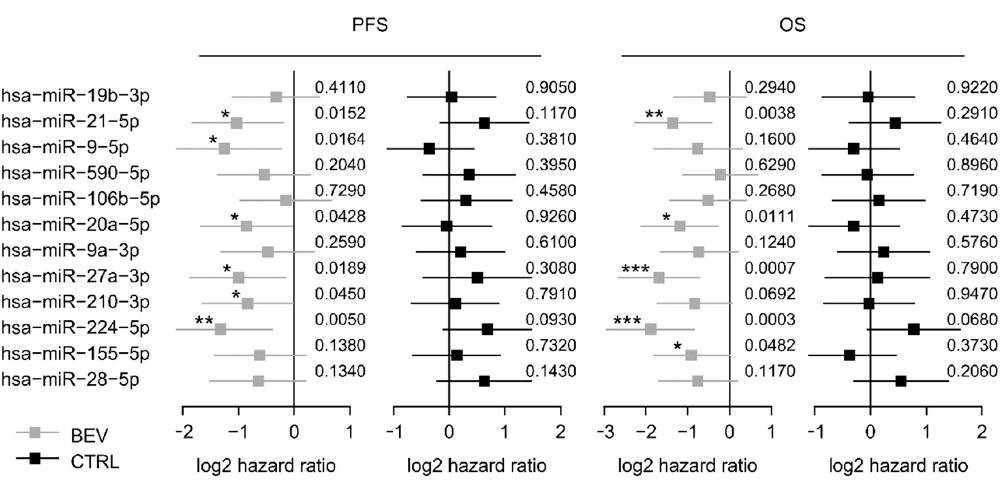
Figure 1. Forest plots for PFS and OS based on the median expression of the selected miRNAs in the screening cohort. Log 2-hazard ratio (HR) and 95%-CI (forest plots) for PFS and OS based on the median expression of the selected miRNAs in the bevacizumab treated group (learning set) and the median expression in the control group treated with chemotherapy alone. (*** p < 0.001, ** 0.001 ≤ p < 0.01, * 0.01 ≤ p < 0.05; exact p values on the right). BEV: bevacizumab, CTRL: control